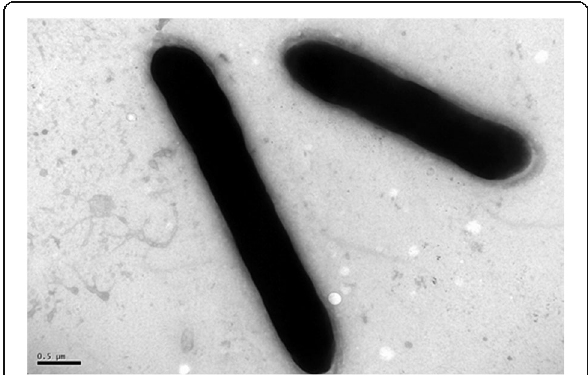
Fig. 1 Scan electron microscope (SEM) image of P. ferrarius CY1 T cells. The bar scale represents 0.5 μ m